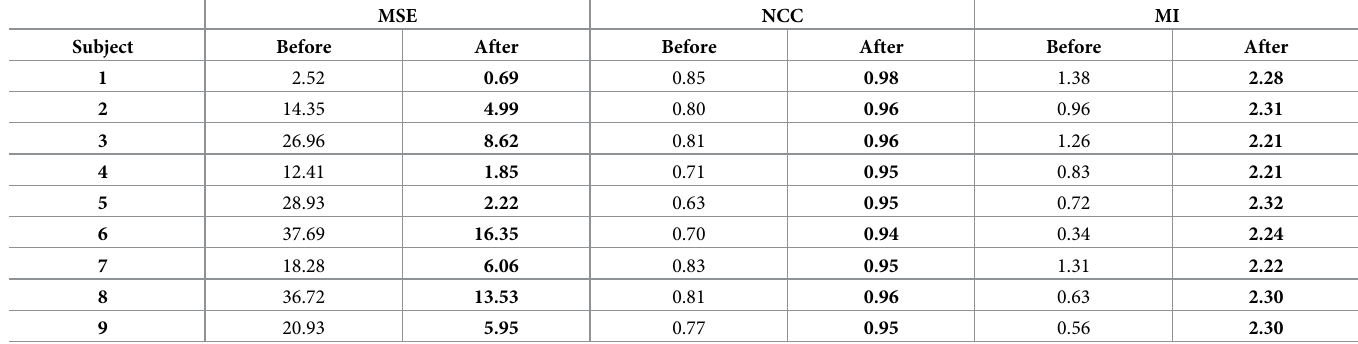
Table 4. Quantitative analysis of the registration results using volume intensity similarity. Mean Square Error (MSE), Normalized Cross Correlation (NCC), and Mututal Information (MI).